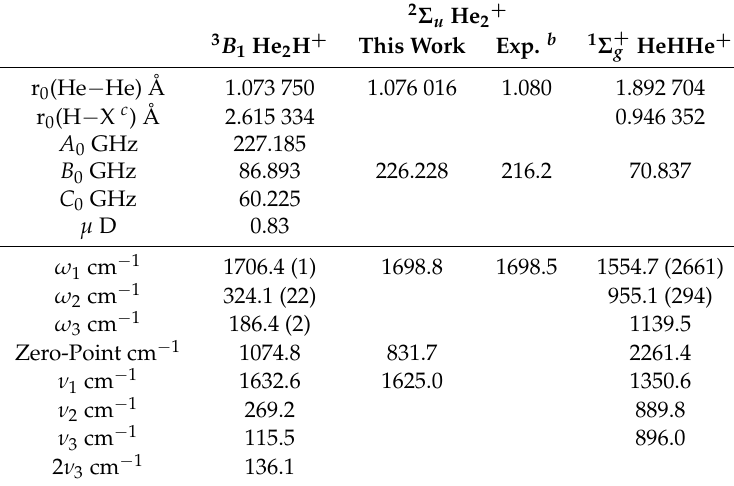
(Intensities a in Parentheses), and Spectroscopic Constants for 3 B 1 He 2 H + , 2 Σ u He 2 + , and 1 Σ + g HeHHe + .